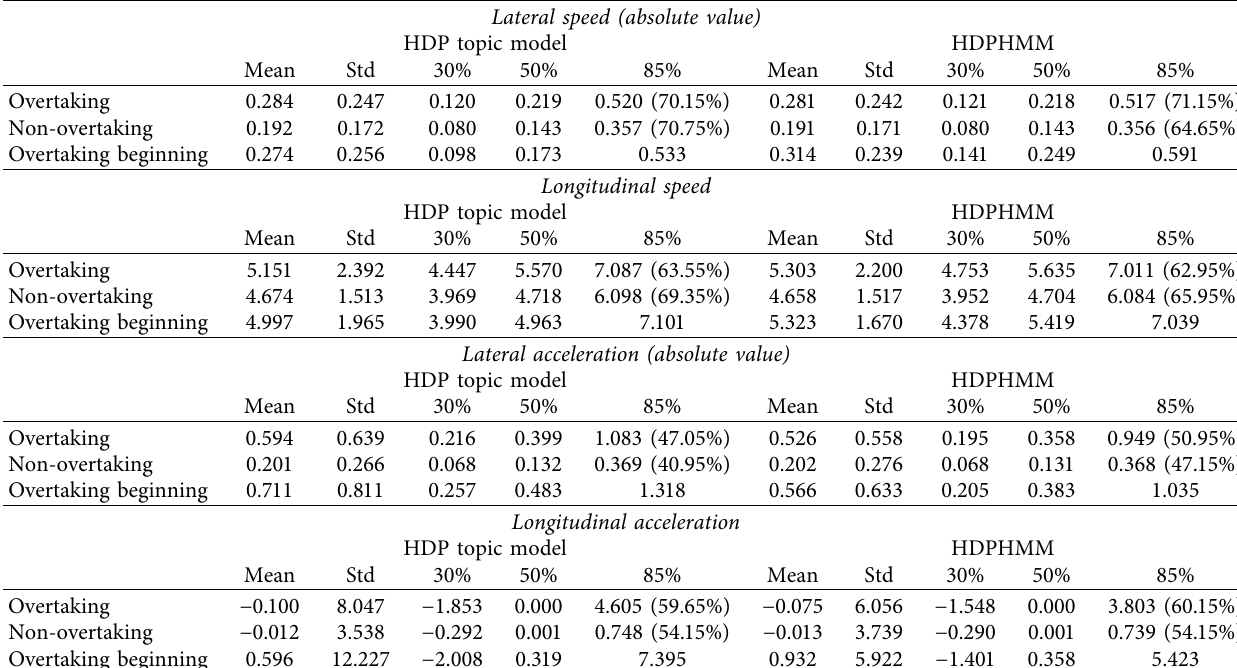
Figure 16: Differences between overtaking state and non-overtaking state identified by automatic Table 1: Cycling features when overtaking begins.